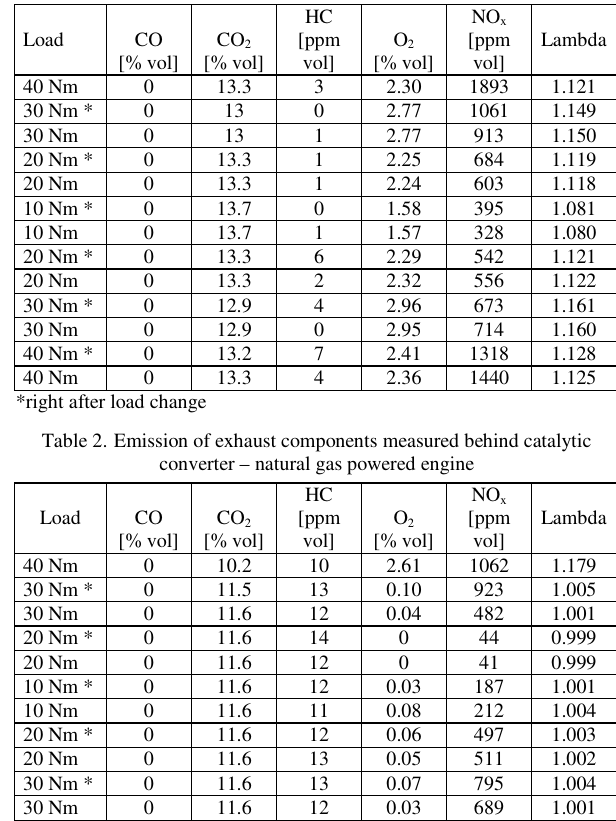
Table 1. Emissions of exhaust components measured behind catalytic converter – petrol powered engine Load